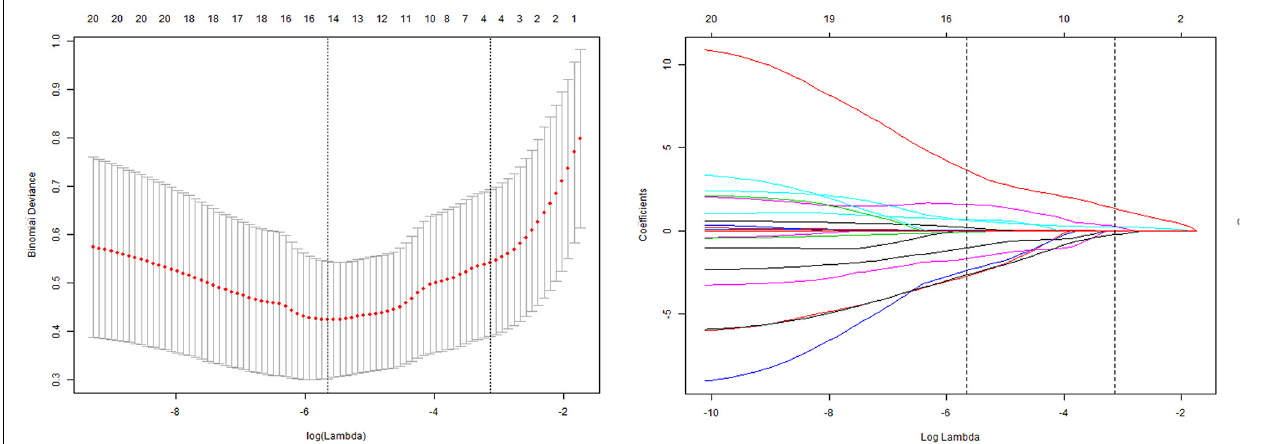
FIGURE 4 | Tuning parameter (lambda) selection in the LASSO model by using 10-fold cross-validation via minimum criteria and 1 standard error of the minimum criteria. Dotted vertical lines were drawn at the optimal values by using the minimum criteria and 1 standard error of the minimum criteria (the 1-SE criteria). The model with the 1-SE criteria was selected. The lambda value of 0.0668, with log (lambda) = –2.70. The model coefficient trendlines of 21 radiomic features; 3 radiomic features were finally included. The formula built by LASSO logistics regression was as follows: score = 0.92 × MPA bifurcation area + 0.50 × MPA outlet hydraulic diameter + 0.10 × MPA outlet